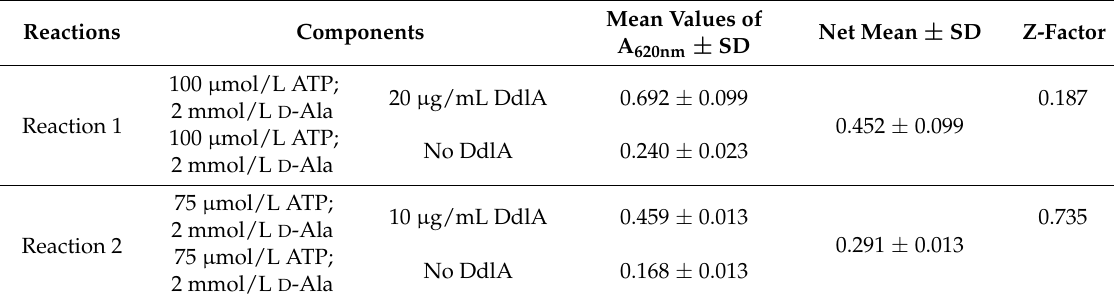
Table 1. The assay of D -alanyl- D -alanine ligase activity on Tb -DdlA. The decreasing D -alanine in the reaction mixture was measured by colorimetric reaction coupled with malachite green reagents. The analysis was conducted in quadruplicate.